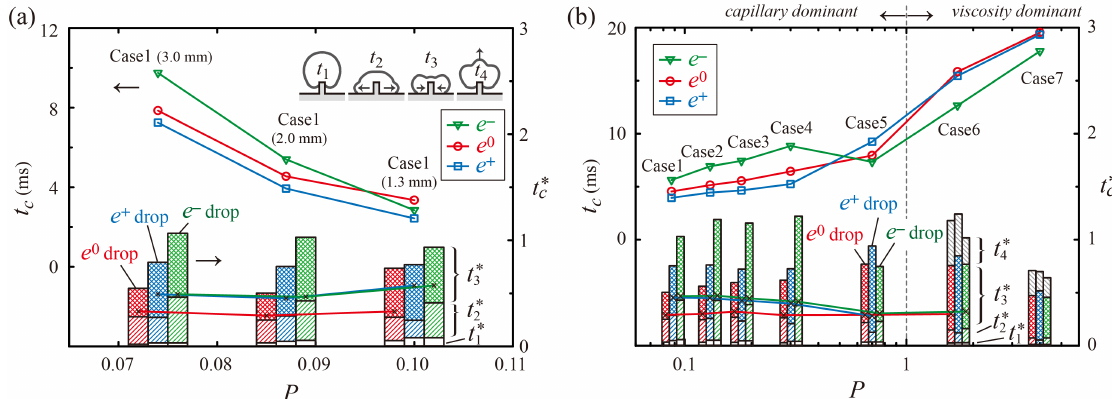
Figure 8. Effect of drop size and liquid properties on reduction in the residence time. ( a , b ) t c (symbol; left axis) and t c * (vertical stack; right axis) as a function of Impact number for ( a ) Case 1 with different D at We = 47 and ( b ) Cases 1–7 at a fixed impact velocity, U = 1.3 m/s. Solid lines within the stacks in ( a , b ) indicate the onset time of drop splitting.